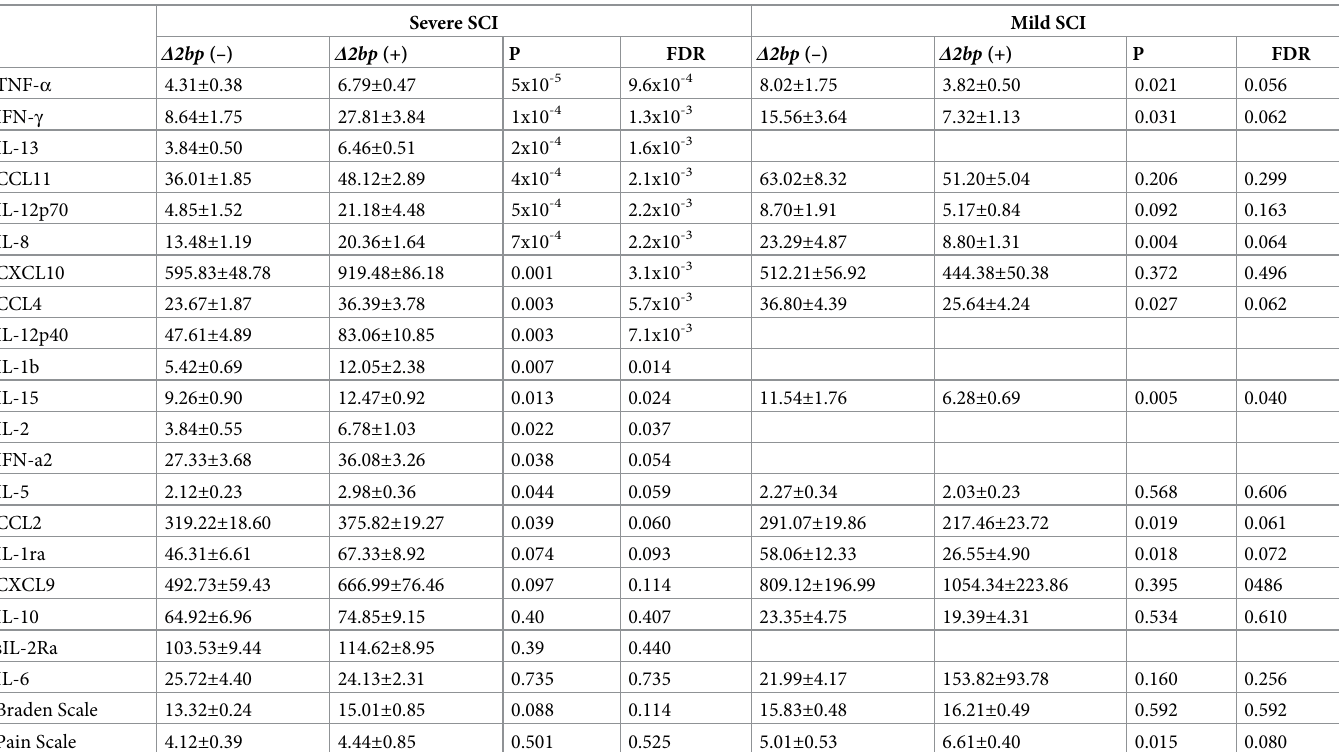
Table 3. Overall genetic effect of CHRFAM7A Δ 2bp